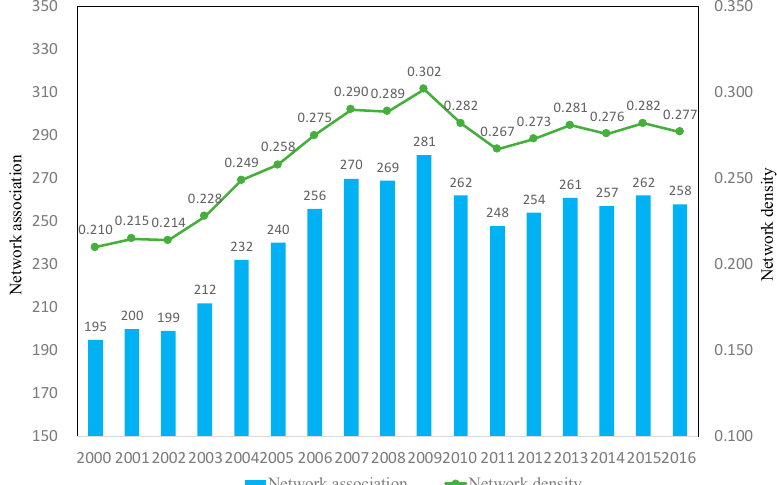
Figure 2. Network density and network association number.